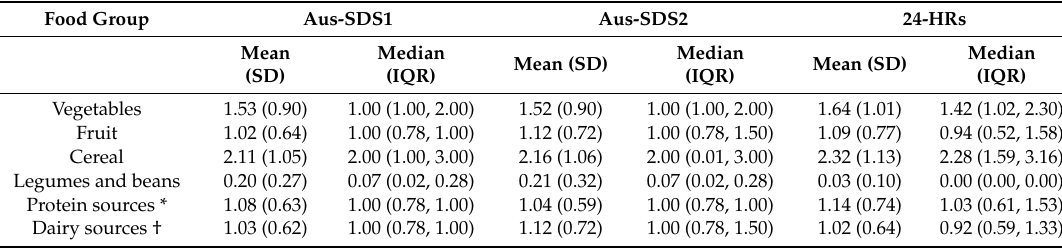
Table 2. Comparison of the median / mean daily food group intake (serves / day) estimated for the Aus-SDS1, Aus-SDS2 and the average of the